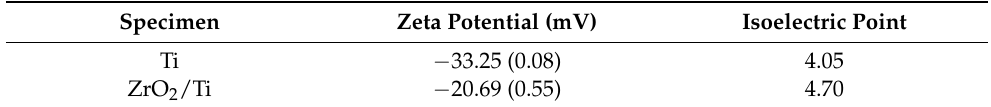
Table 2. Apparent zeta potentials at a pH level of 5.6, and the isoelectric points of the Ti and ZrO 2 /Ti specimens.